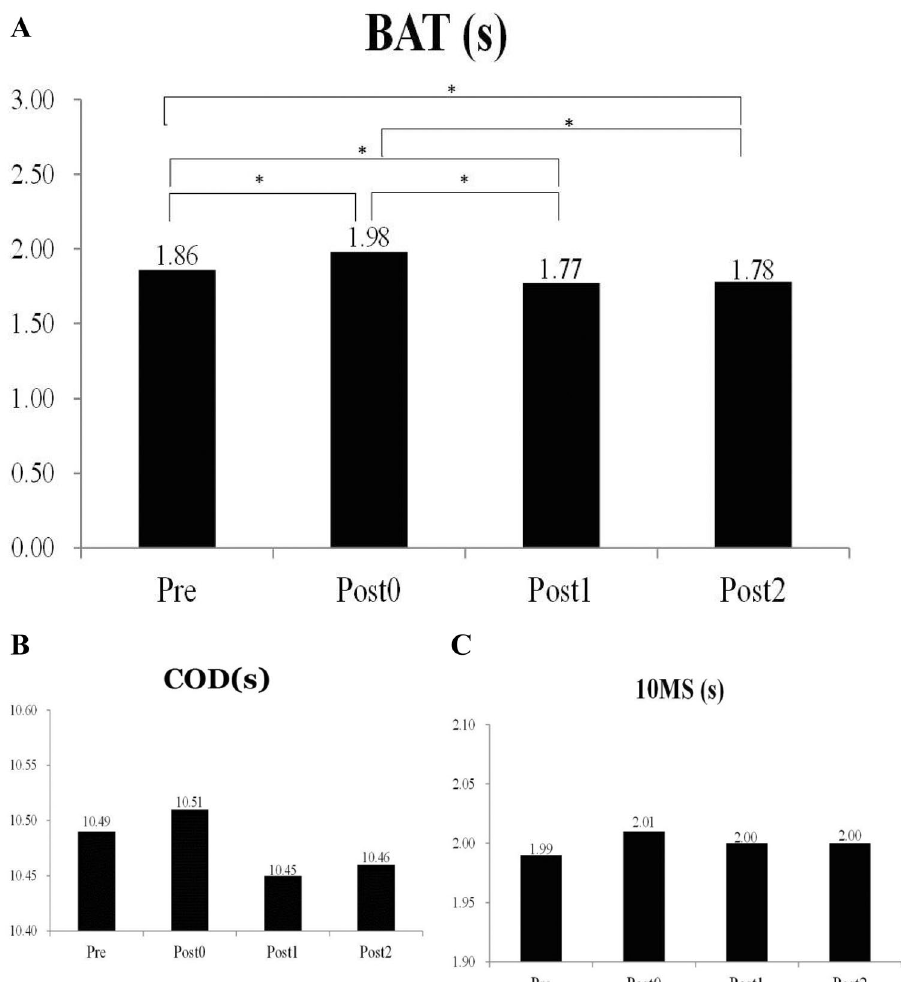
Figure 1. Blocking agility test ( A ) & special physical fitness (Change of direction ( B ) & 10 m sprint ( C )) percentage difference. Data are expressed as the mean (n = 20) ± standard error. All experiments were performed in four. The statistical analysis of differences was performed using one-way analysis of variance (group × time) of variance. p < 0.05 was considered to indicate a statistically significant difference. Asterisk indicates significant difference compared to